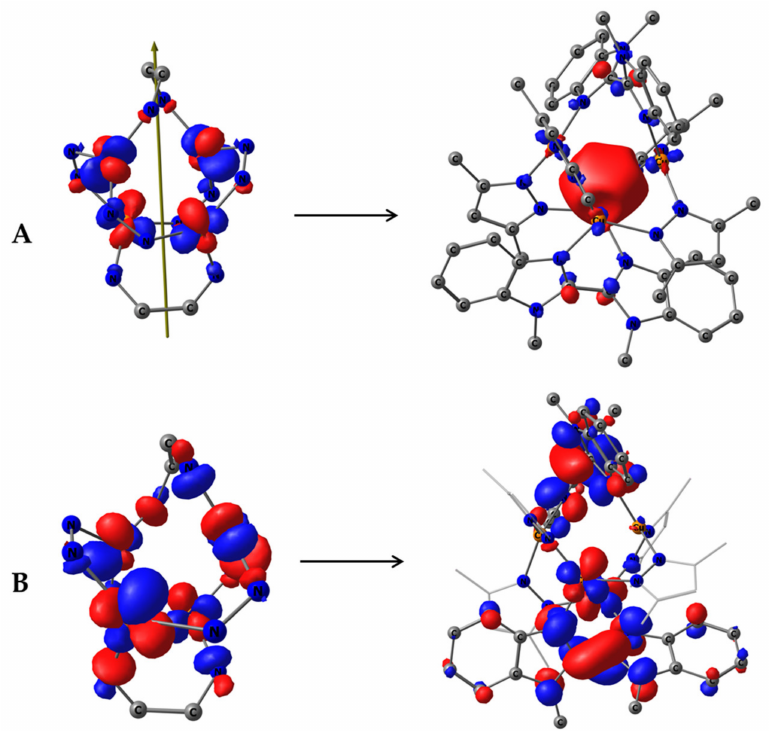
Figure 9. ( A ) Symmetry-allowed HONTO-2 (left, demonstrating only the central M 4 N 12 C 4 core) and LUNTO+2 (right) (27% of transition electron density) of S 0 → S 1 transition in complex 1 restricted to S 4 symmetry; ( B ) Symmetry-forbidden sum. HONTO and HONTO-1 (left, demonstrating only the central M 4 N 12 C 4 core), sum. LUNTO and LUNTO+1 (right) (70% of transition electron density) of S 0 → S 1 transition in complex 1, restricted to S 4